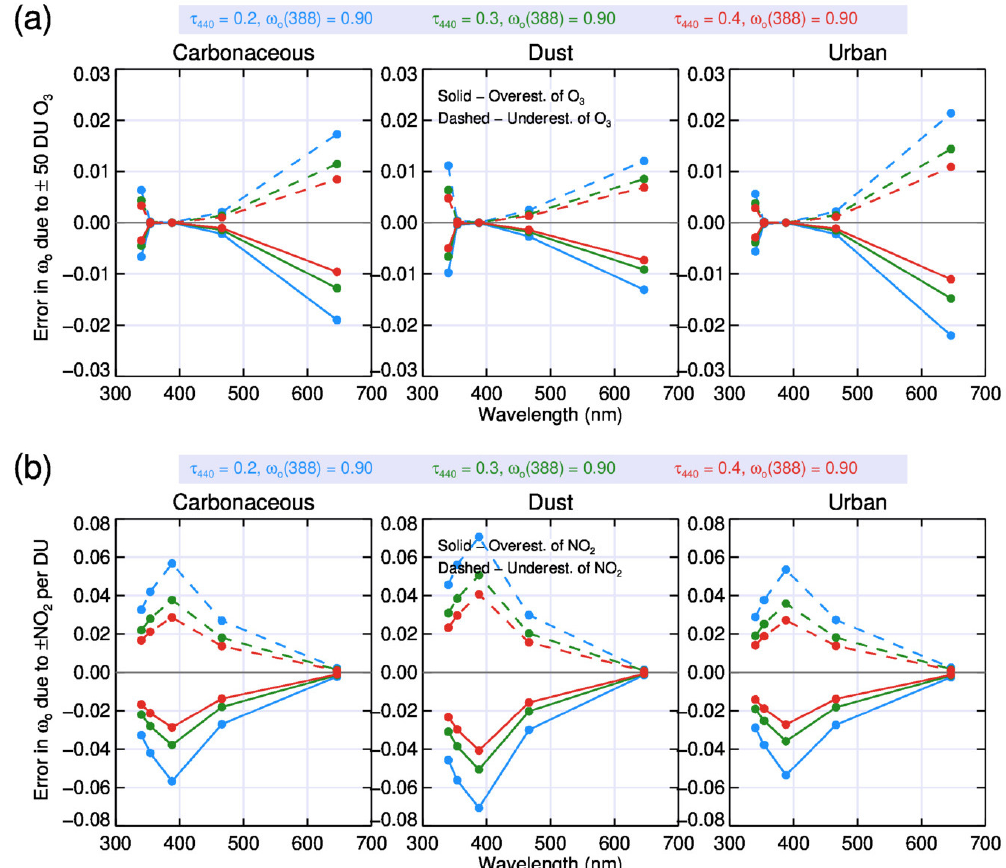
Figure 7. Theoretical uncertainty in SSA retrievals due to (a) ± 50DU O 3 and (b) ± 1DU NO 2 concentrations. Solid and dashed lines represent the overestimation and underestimation of the corresponding input